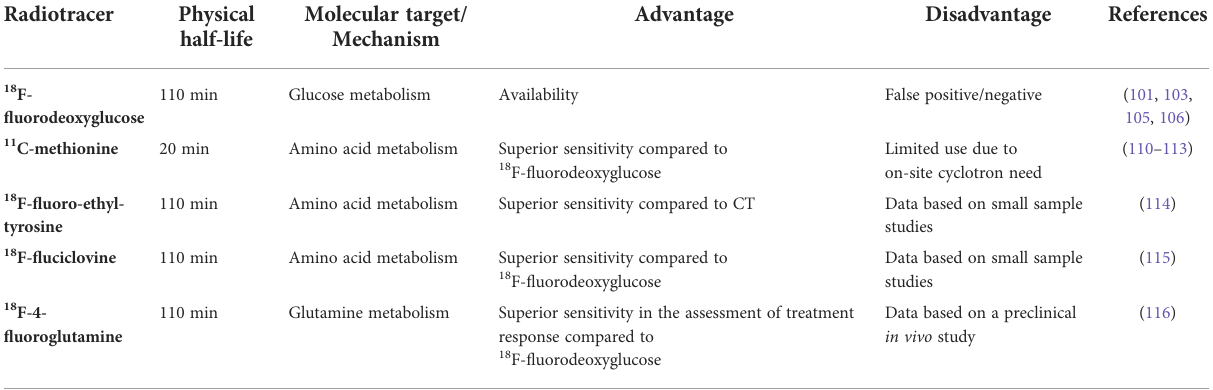
TABLE 1 Radiotracers explored for MM imaging discussed in this